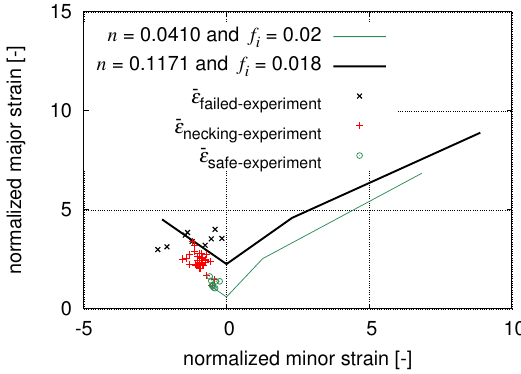
Figure 22. Forming limit band as a function of major-minor strains (normalized with respect to the mean uniform strain) with experimental strains from uniaxial loading